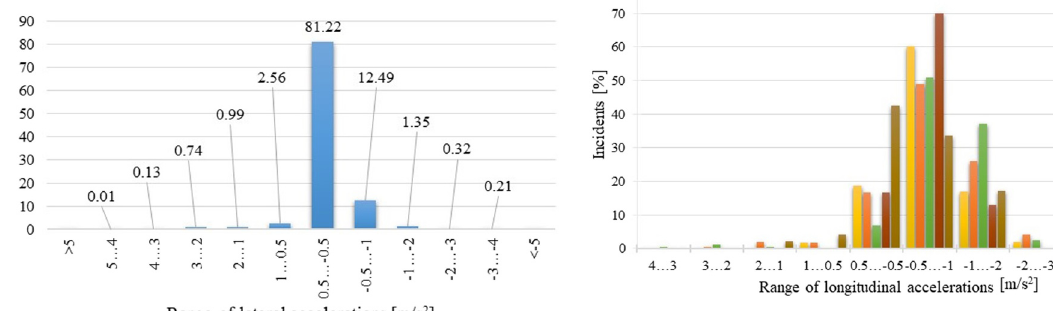
Figure 13: The frequency of occurrence of particular values of lateral acceleration – morning drive.